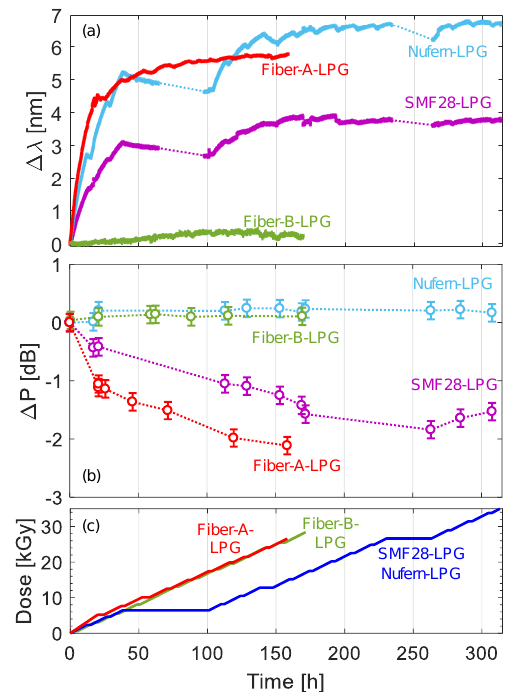
Figure 30. Real-time results of the gamma irradiation of LPGs arc-induced in different optical fibers: ( a ) resonance wavelength shift; ( b ) transmitted optical power changes; ( c ) irradiation profiles. (adapted from Ref. [147]).